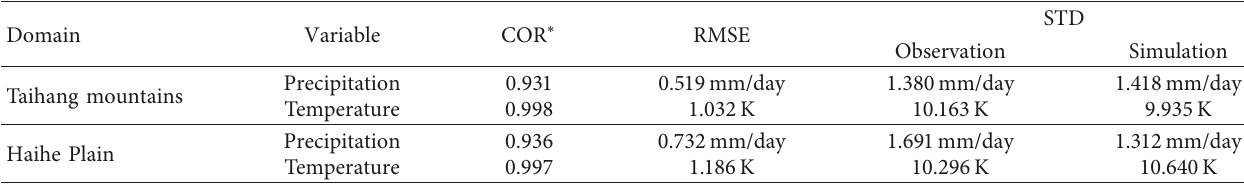
Figure 4: Spatial distributions of mean (a) observed precipitation, (b) precipitation simulated by the control test, (c) observed 2m air temperature, and (d) 2m air temperature simulated by the control test. Table 3: Statistics of control test in the Taihang Mountains and Haihe